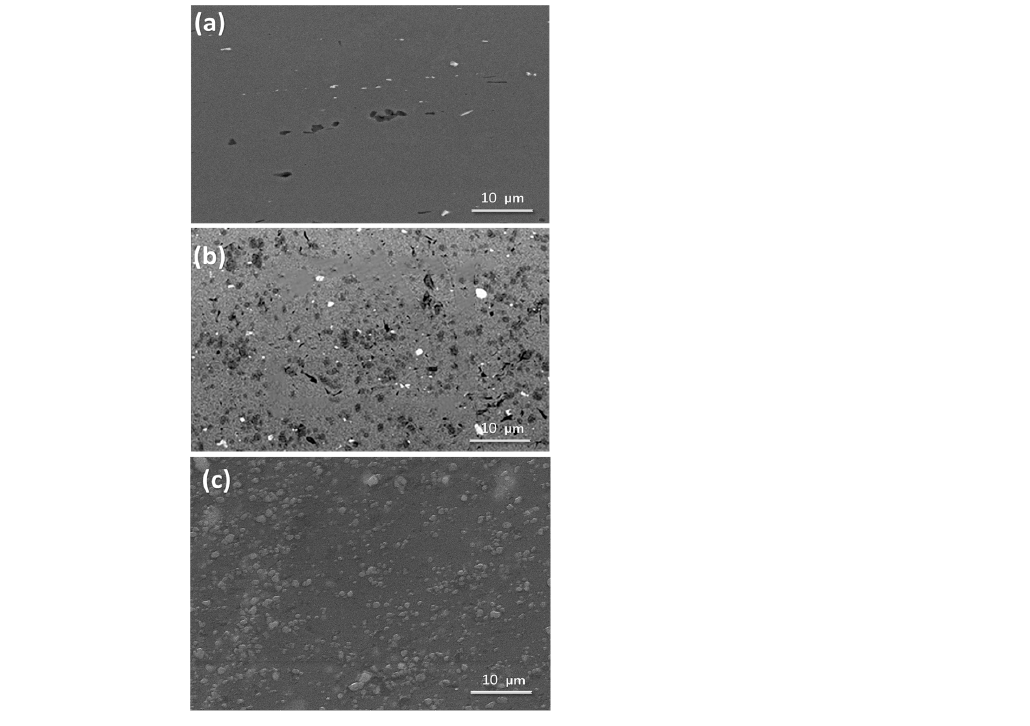
Figure 5. EDS mapping images of the hybrid composite AA7075/ GNP+BN+VC.